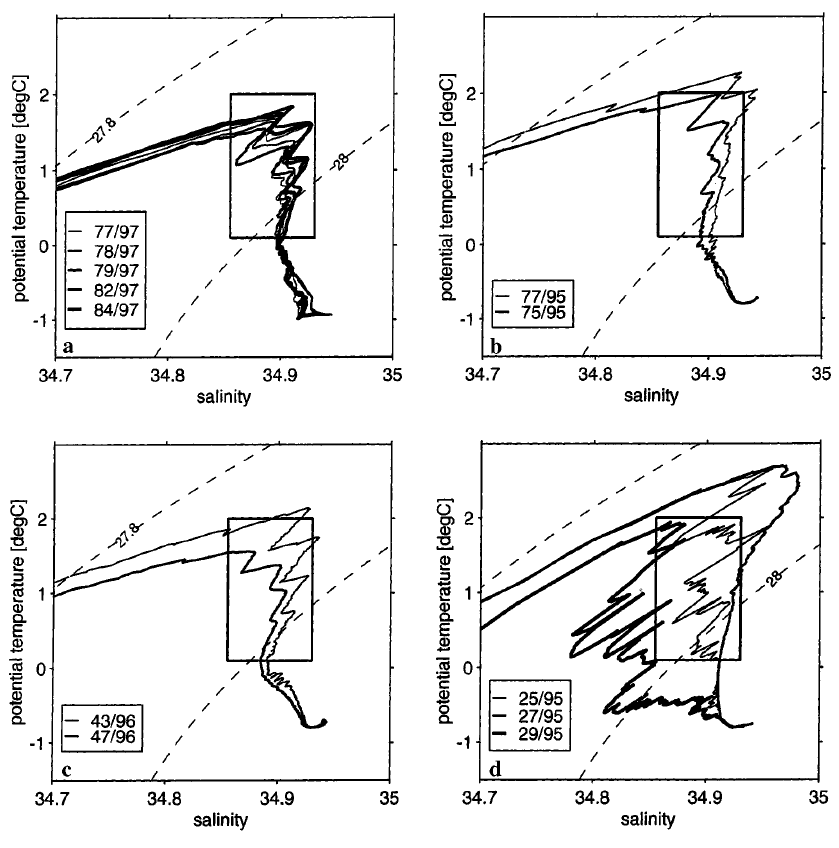
Fig. 9a–d. Q -S diagrams showing the in- terleaving structures observed on a section III, and b in the interior of northern Nansen Basin and over the Nansen Gakkel Ridge in 1995, and c in 1996, and d the interleaving between the Fram Strait and the Barents Sea branches north of Severnaya Zemlya in 1995. The boxes are inserted to better show the Q -S range of